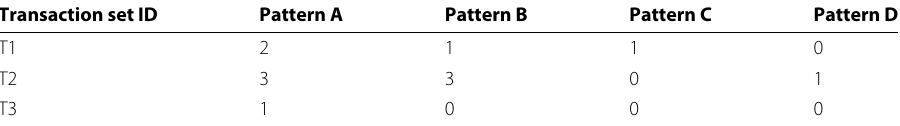
Table 3 Examples of featurized sets of